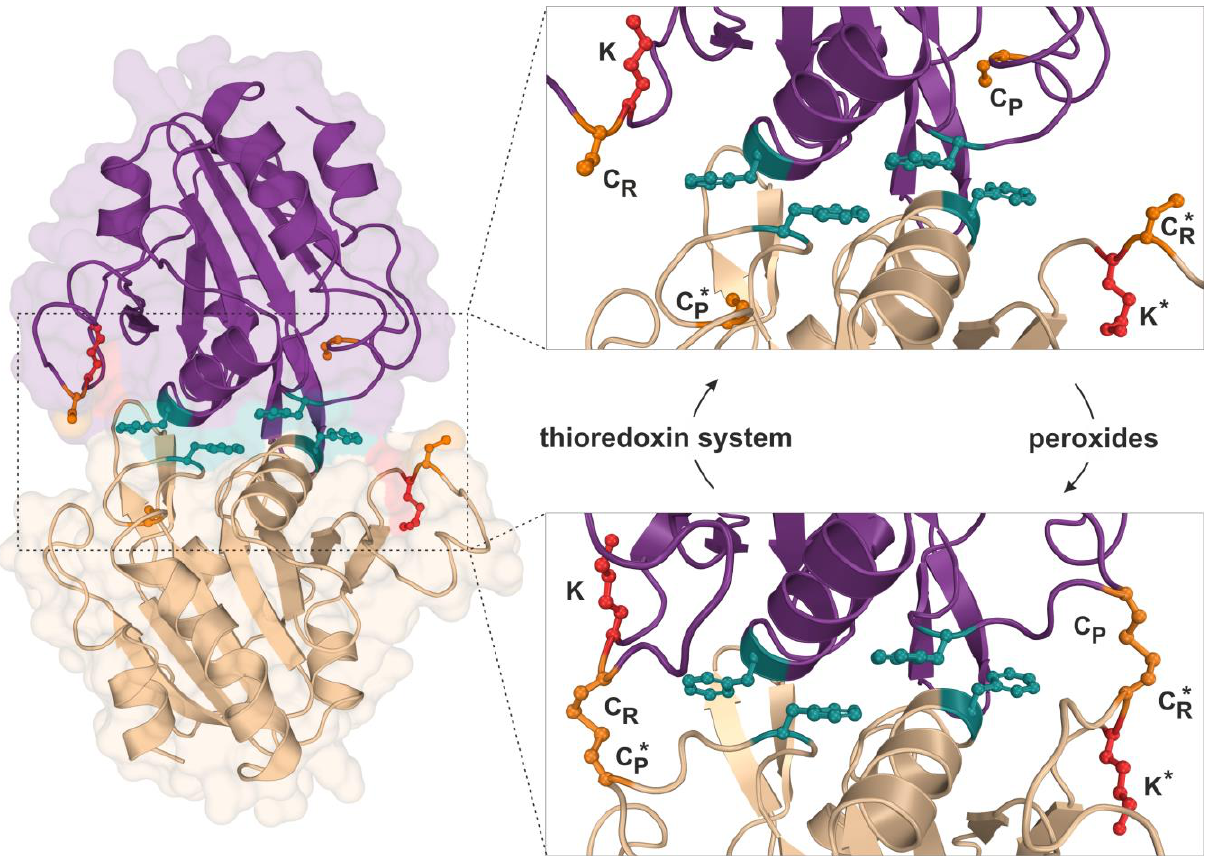
FIGURE 2: Structure and catalytic cycle of the peroxiredoxin Ahp1 from S. cerevisiae . Ribbon diagram presentation of the dimeric Ahp1 enzyme with its two subunits (magenta & wheat) in its reduced form (PDB: 4DSR). Residues critical for peroxidase activity (orange), dimeriza- tion (teal) and Urm1 conjugation (red) are highlighted. The enlarged insert focusses on the hydrophobic homodimer interface. In its reduced form (top panel), the peroxidatic cysteine (Cys-62: C P ) is buried inside the active center. Upon oxidation by peroxides, the C P approaches the resolving cysteine of the opposite subunit (Cys-31: C R *) leading to formation of intersubunit disulfide bridges (bottom panel, PDB: 4DSQ). These are subsequently reduced by the thioredoxin system. Note that next to each C R is a lysine residue (Lys-32: K) previously reported to function as the sole site for Ahp1 urmylation